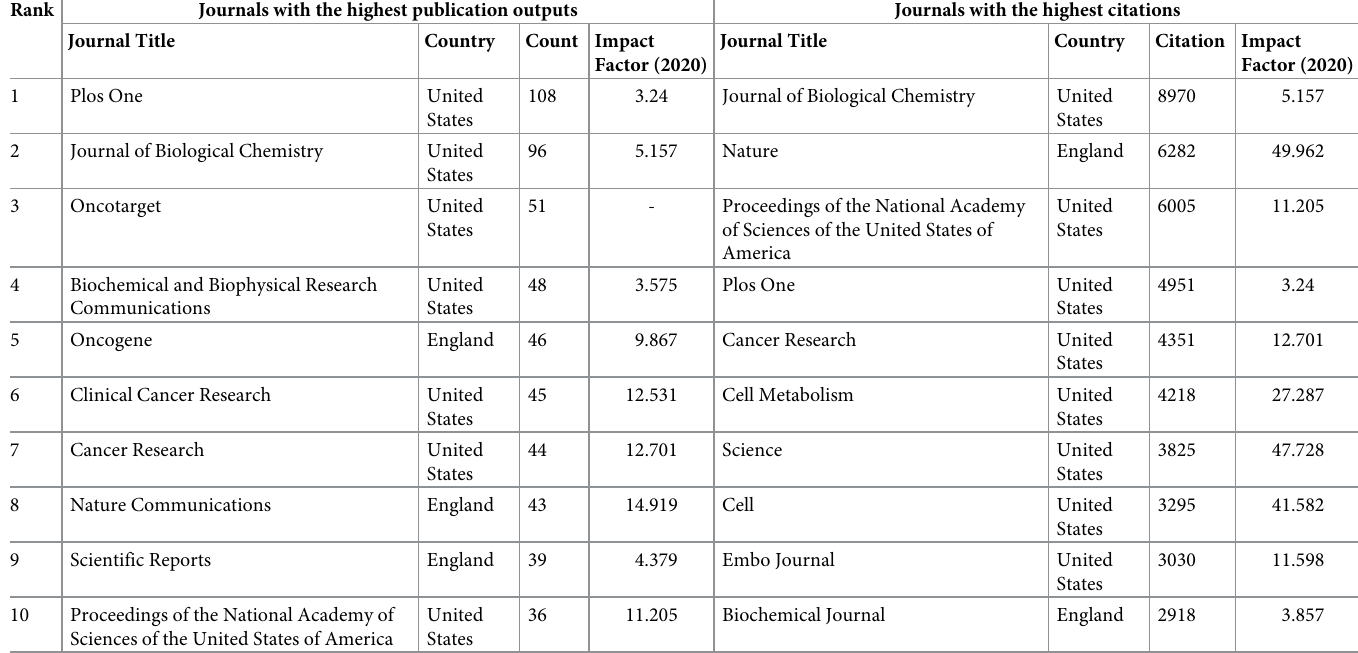
Table 4. Top 10 source journals for LKB1 articles, 2000 to 2021.